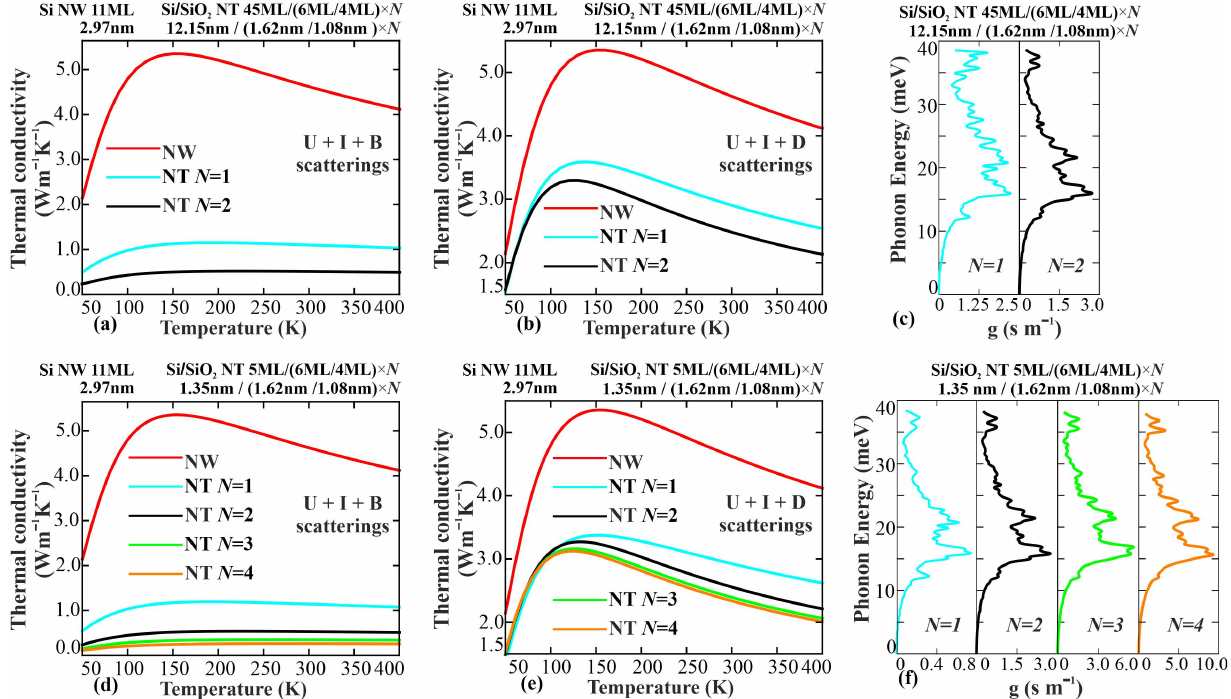
Figure 4. Temperature dependence of the TC (thermal conductivity) ( a , b , d , e ) and phonon DOS (density of states) ( c , f ) in Si/SiO 2 MNTs. The TC is calculated considering the phonon Umklapp and boundary scatterings ( a , d ) as well as the phonon Umklapp scattering and “effective scattering rate” due to diffusion of vibrational excitations in SiO 2 ( b , e